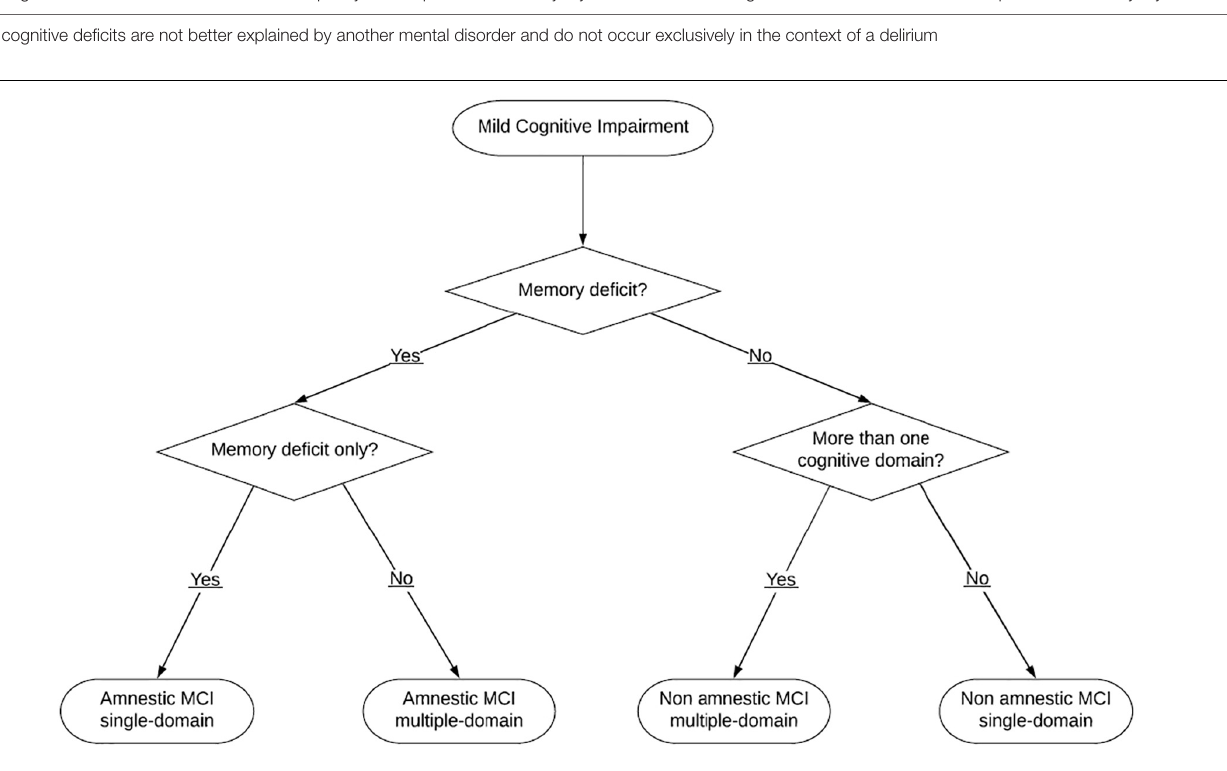
FIGURE 1 | Clinical subtypes of